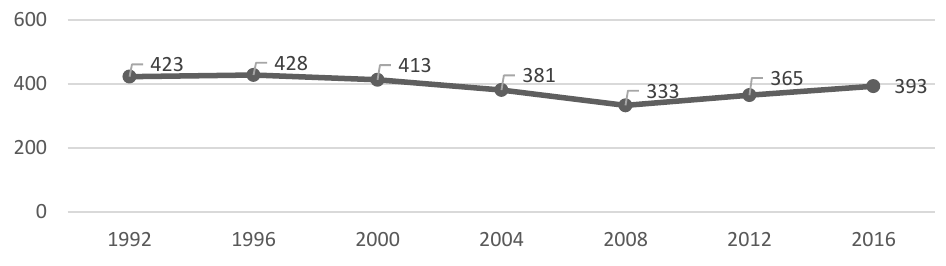
Figure 2. Silver medals evolution over all the editions.